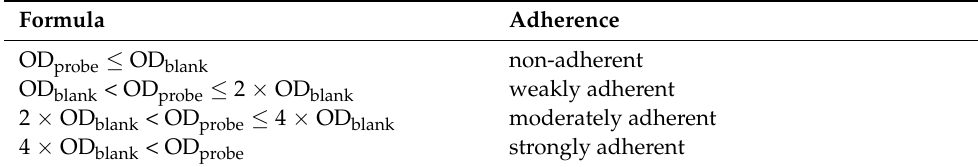
Table 5. Correlation between the optical density of samples and bacterial adherence [47].